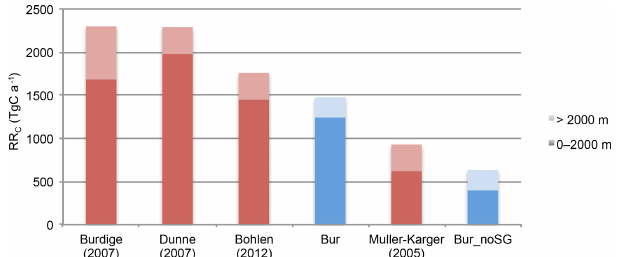
Figure 4. Globally integrated pre-industrial rain rate of particulate organic carbon (RR C ) to the seafloor in TmolCa − 1 from published studies (red) and for UVic model simulations (blue) between 0 to 2000m water depth (dark blue) and below 2000m (light blue). The simulation Bur is representative for all UVic model simulations ex- cept Bur_noSG